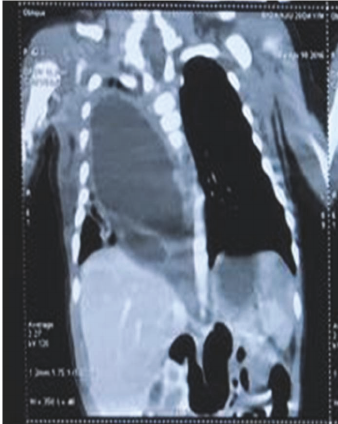
Figure 2: Computed tomography scan showed a well-defined fluid attenuation lesion with broad base towards the mediastinum with few loculations.